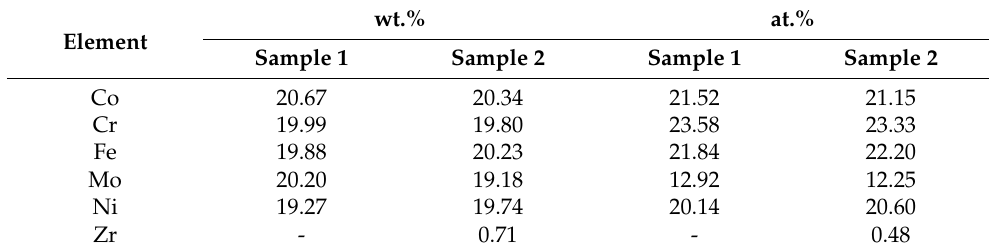
Table 1. Chemical composition of the experimental alloys. Element